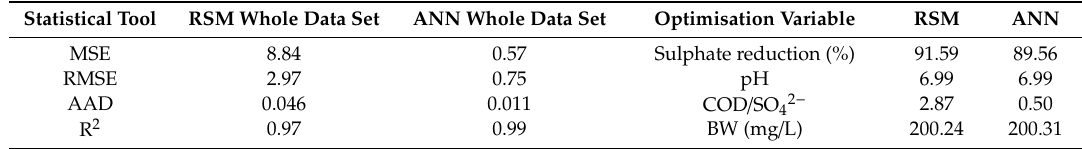
Table 5. Statistical measurement of the RSM and ANN data sets for model